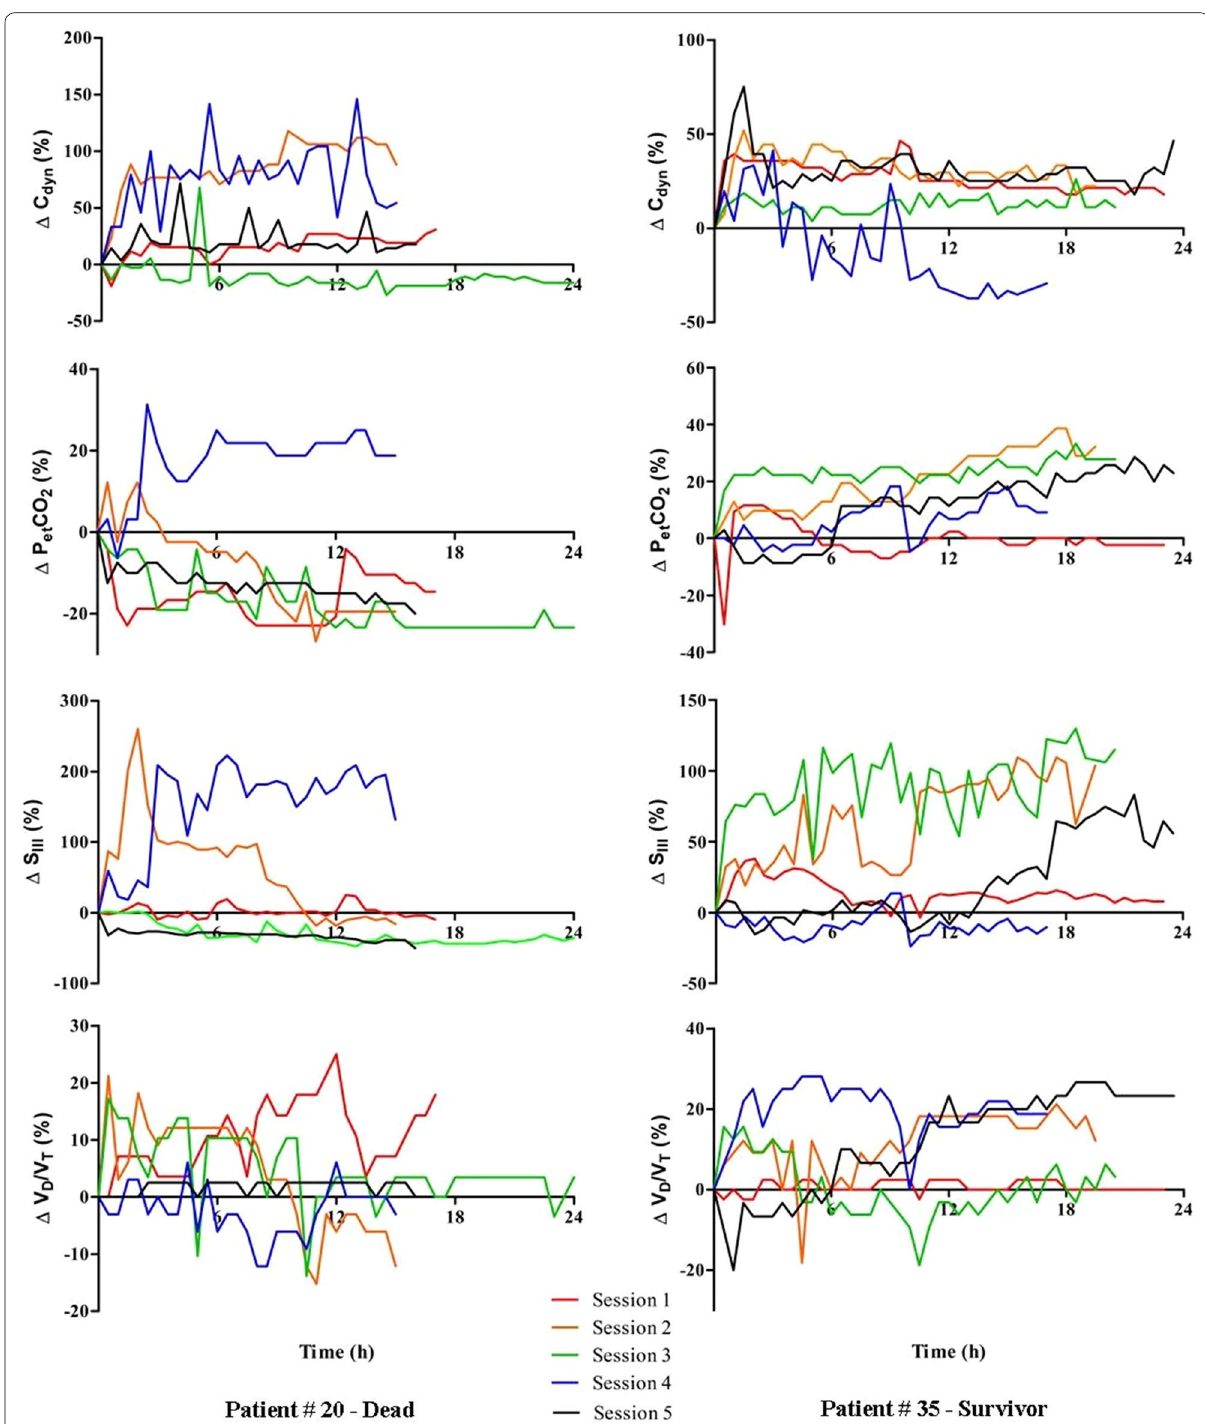
Fig. 3 Evolution over five consecutive prone position sessions of Δ C dyn , Δ P et CO 2 , ΔS III and Δ V D / V T‑phy , in patient #20 (dead) and patient #35 (survivor), from 0 h (just before prone positioning) to the end of each prone position